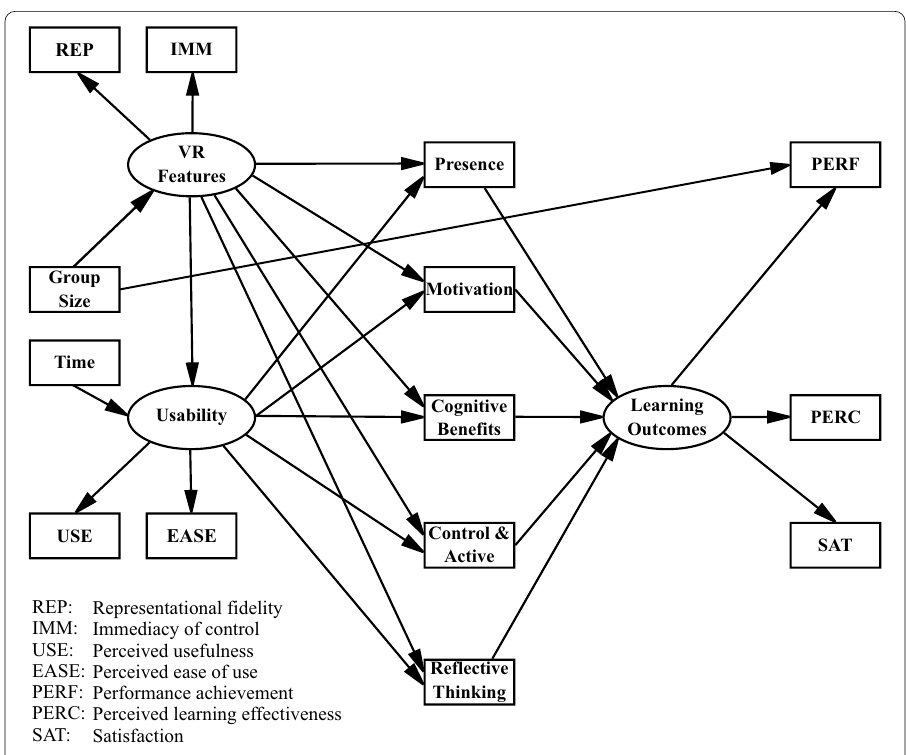
Fig. 2 Measurement model as adopted from Lee et al. (2010), extended with the manipulated variables group size and time of application. Arrows indicate the hypothesized causal relationships between the variables in the